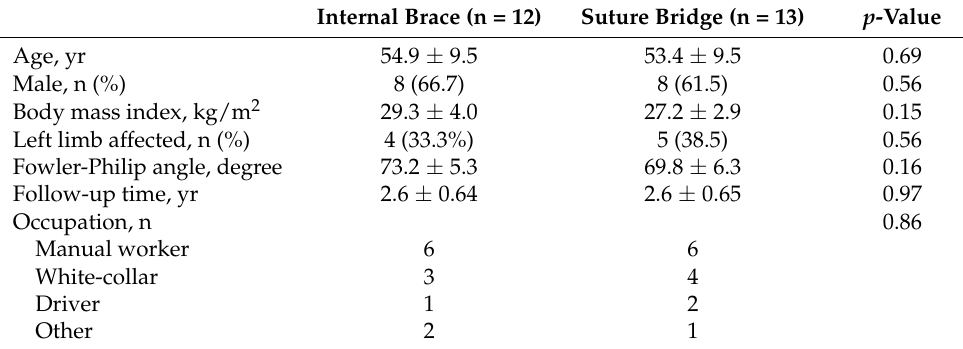
Table 1. General characteristics of the